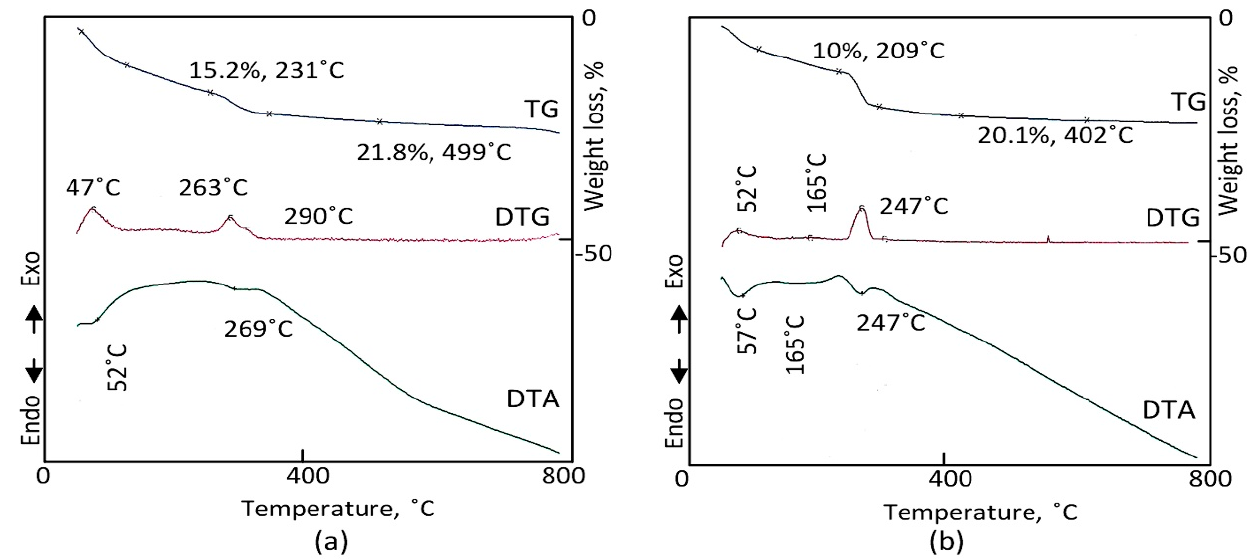
Figure 10. Thermal analyses of CSLDH-2 in presence of: ( a ) nitrogen gas and ( b ) air.